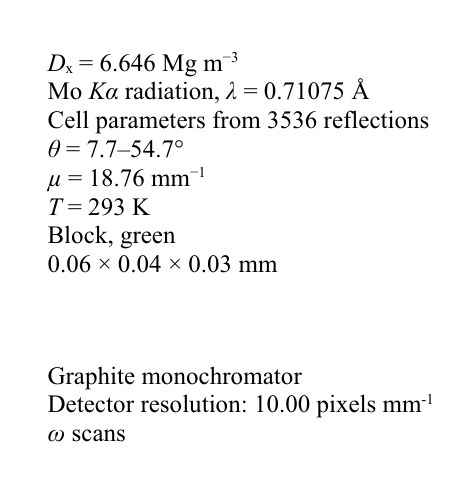
The O-atom coordination around the cation sites of BaCo are drawn at the 99% probability